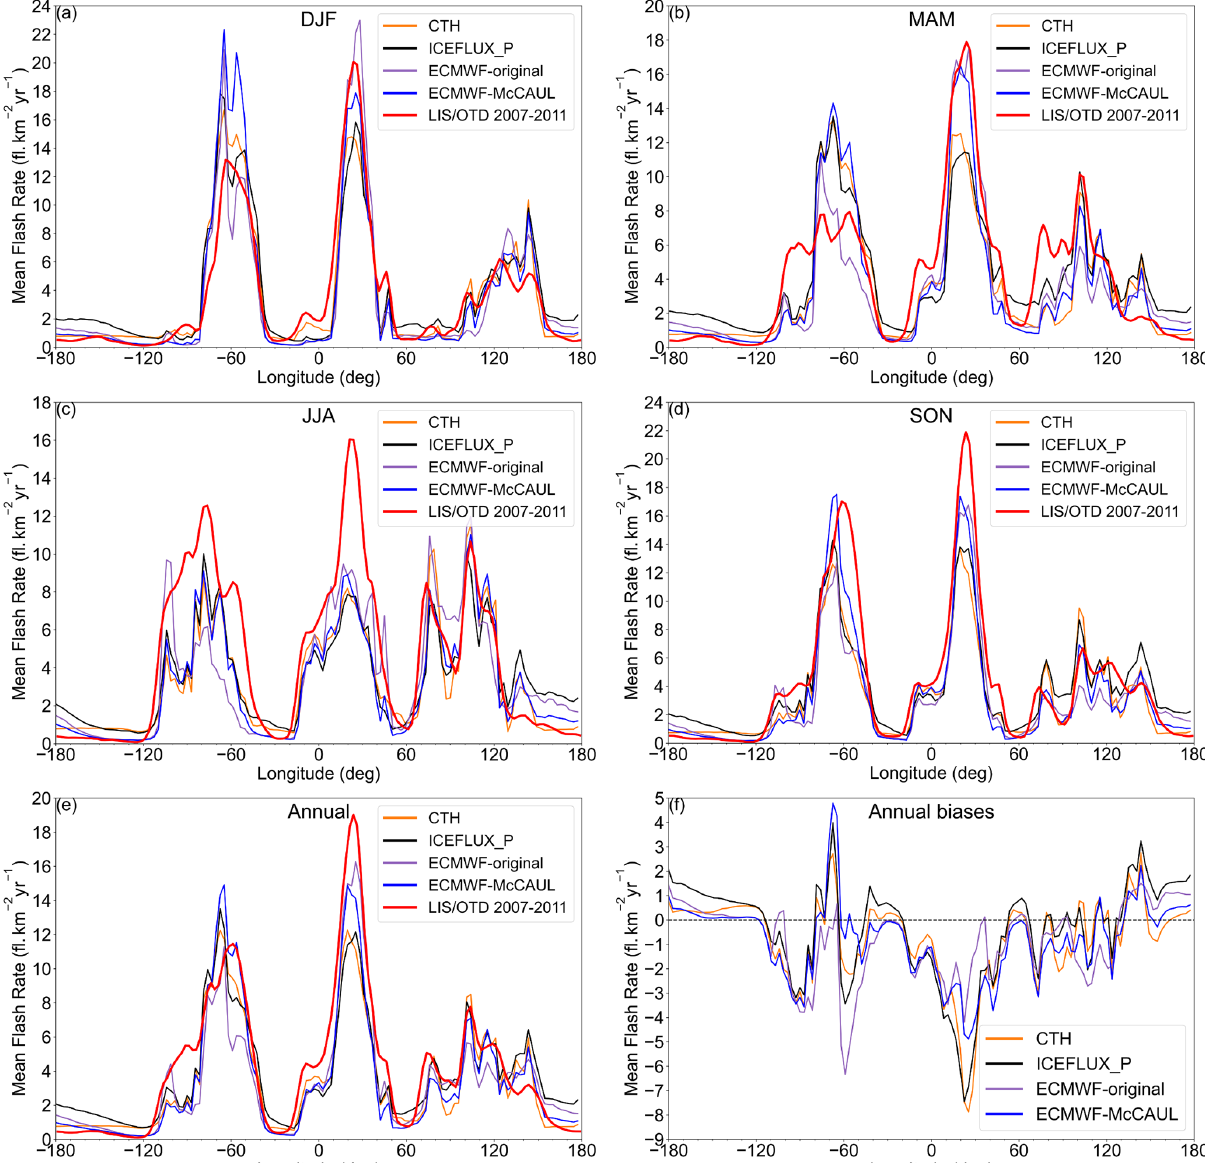
Figure 5. Seasonal and annual meridional average lightning flash density distribution from the LIS 2007–2011 climatology (red line) and from simulation results (2007–2011) obtained using different lightning schemes. The meridional average is only taken within the LIS viewing region of ± 38 ◦ latitude. The biases (model − obs.) in panel (e) are also portrayed in panel (f)